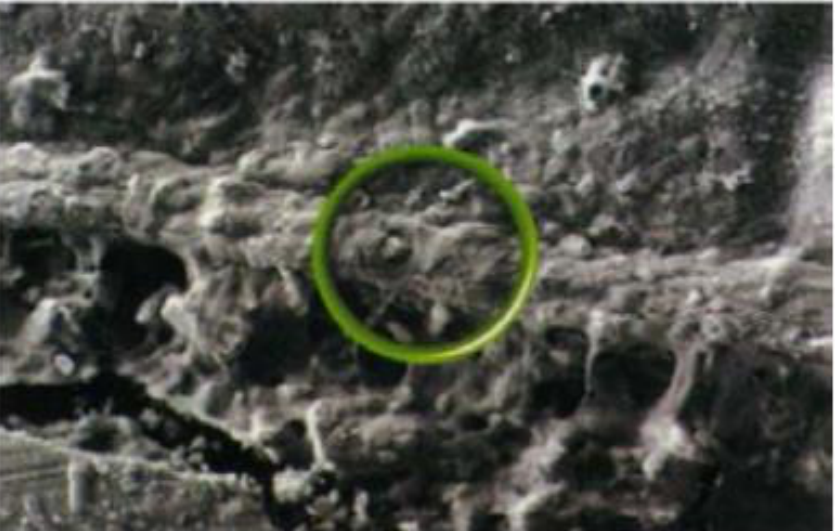
Figure 2. SEM Analysis representing Interfacial ion-exchange layer formed between tooth surface (above) and glass-ionomer cement (below). The circle indicates part of the ion-exchange layer. Reprinted from ref . [1].